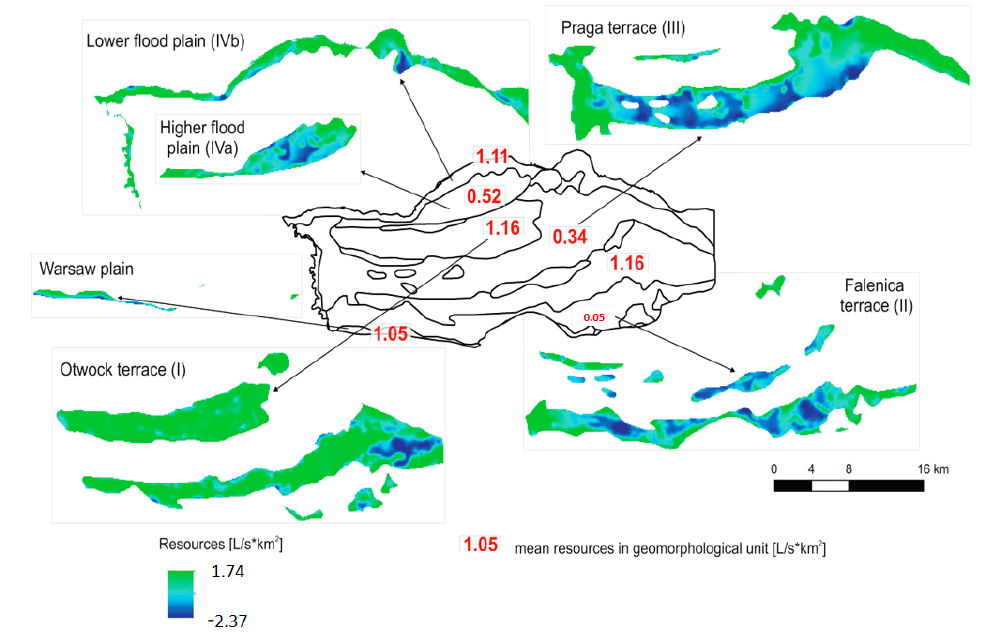
Figure 9. Spatial distribution and average values of renewable resources in geomorphological units in variant 1.